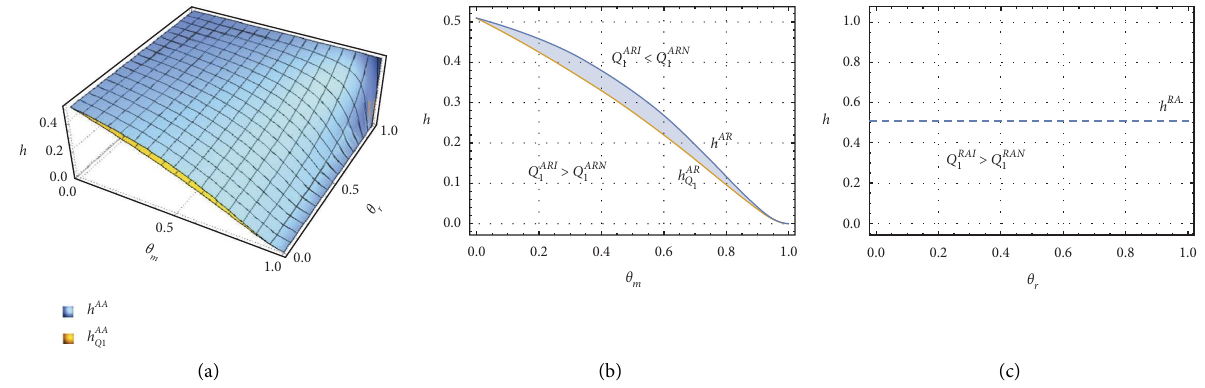
Figure 3: Tresholds of the frst-period order quantities for diferent altruistic scenarios ( a � 1 , b � 0 . 5 ,c � 0 . 2 , c � 1 ) . (a) Both members are altruistic. (b) Only the manufacturer is altruistic. (c) Only the retailer is